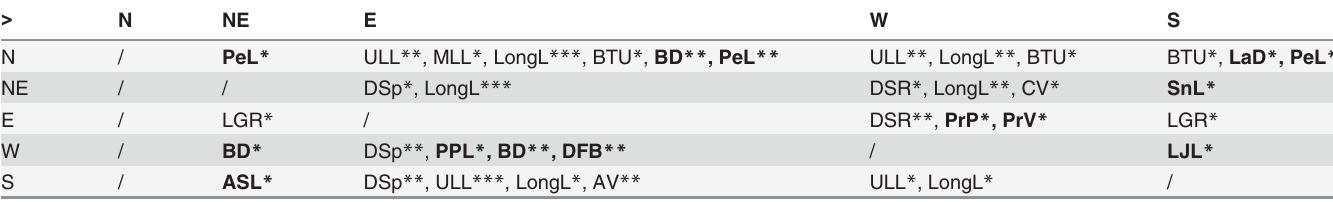
Table 6. Summary of pairwise Mann-Whithey U tests between 5 groups of S . babaulti and S . pleurospilus .